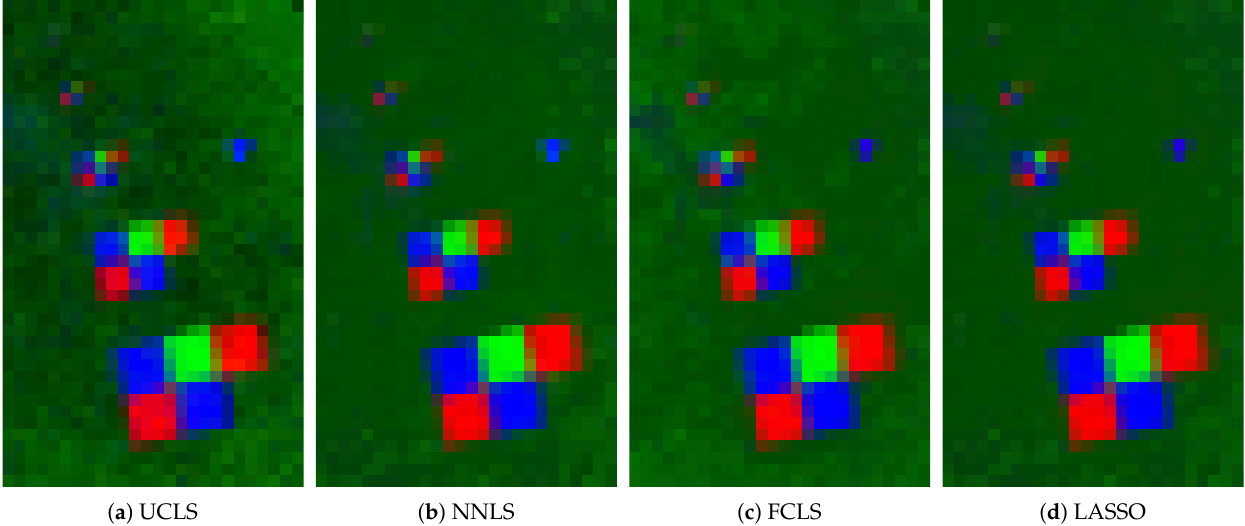
Figure 13. Abundance maps obtained by spectral unmixing for the DLR HySU benchmark. The results for UCLS, NNLS, FCLS and LASSO ( λ = 1) are combined in a single RGB representation. The abundances (stretched from 0 to 1) are color-coded as follows: red metal and red fabric in red, green fabric and grass in green, bitumen and blue fabric in blue. The grass abundance was rescaled from 0 to 0.3 in order not to hide the boundary with green fabric.